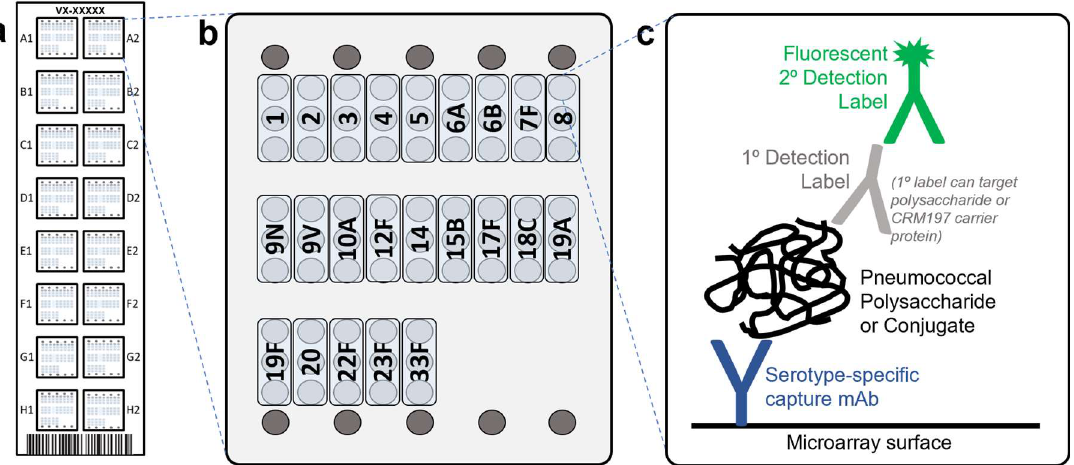
Figure 1. Design of VaxArray pneumococcal assay. ( a ) Schematic representation of the VaxArray pneumococcal assay kit microarray slide showing 16 replicate microarrays, A1-H2 represents the location of each microarray; ( b ) individual microarray layout showing 3 replicate spots for each serotype, with fiducial markers in grey at top and bottom; and ( c ) general assay detection scheme showing serotype-specific capture with primary detection and fluorescent secondary detection la- bel. The primary label can either target polysaccharide or CRM197 carrier protein. (For interpreta- tion of the references to color in this figure legend, the reader is referred to the web version of this article).